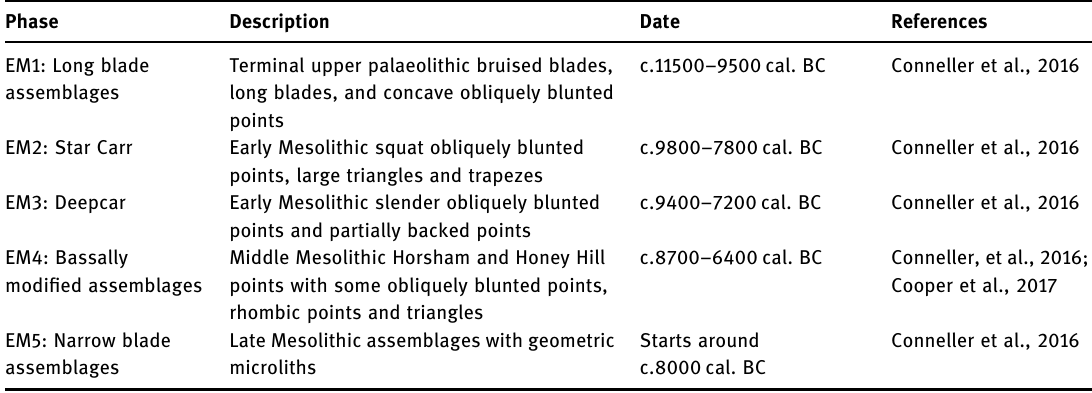
Table 1: Typical phases of the Mesolithic of Britain with corresponding nomenclature for Bexhill Phase